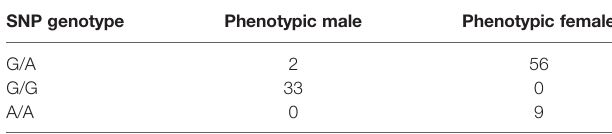
TABLE 2 | SNP genotype and phenotypic sex of the Strongylocentrotus intermedius . SNP genotype